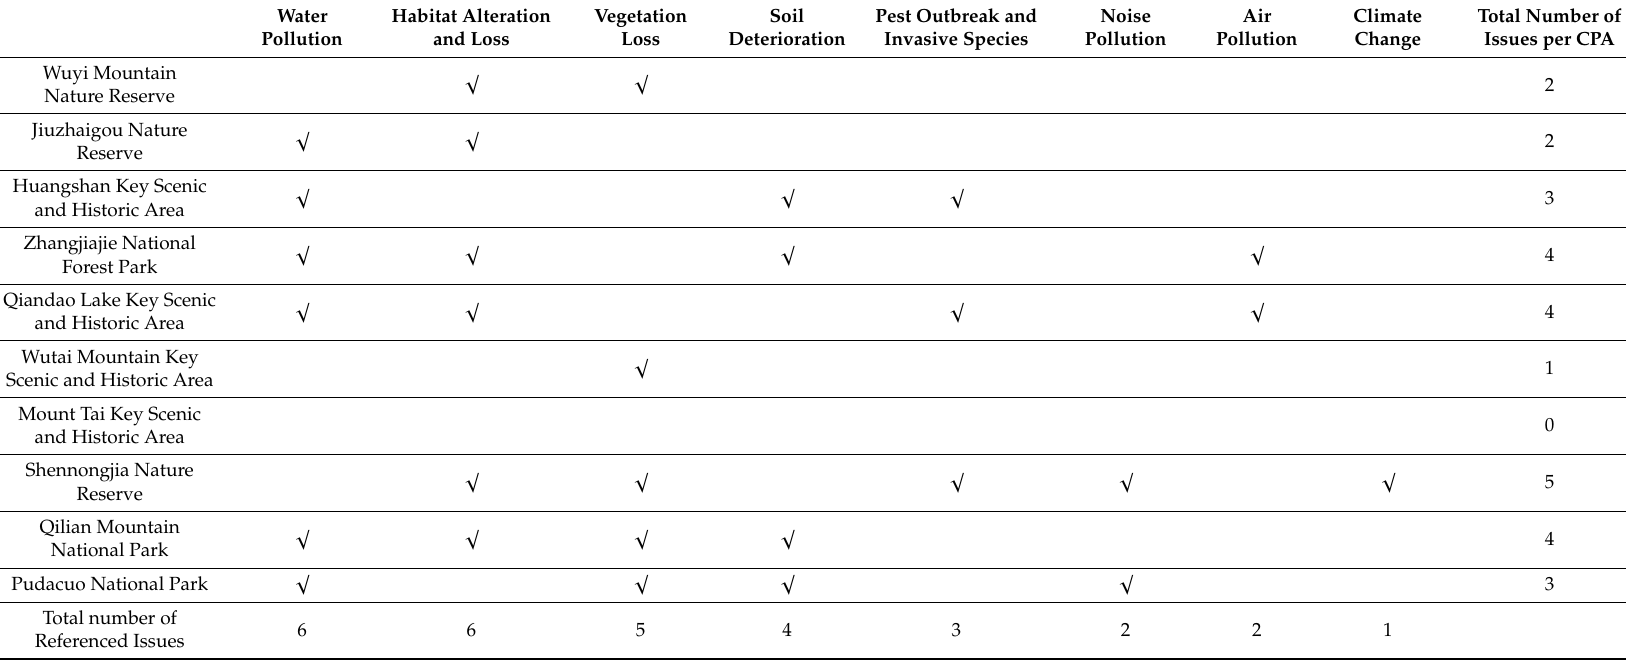
Table 2. Environmental issues in the selected sites according to the